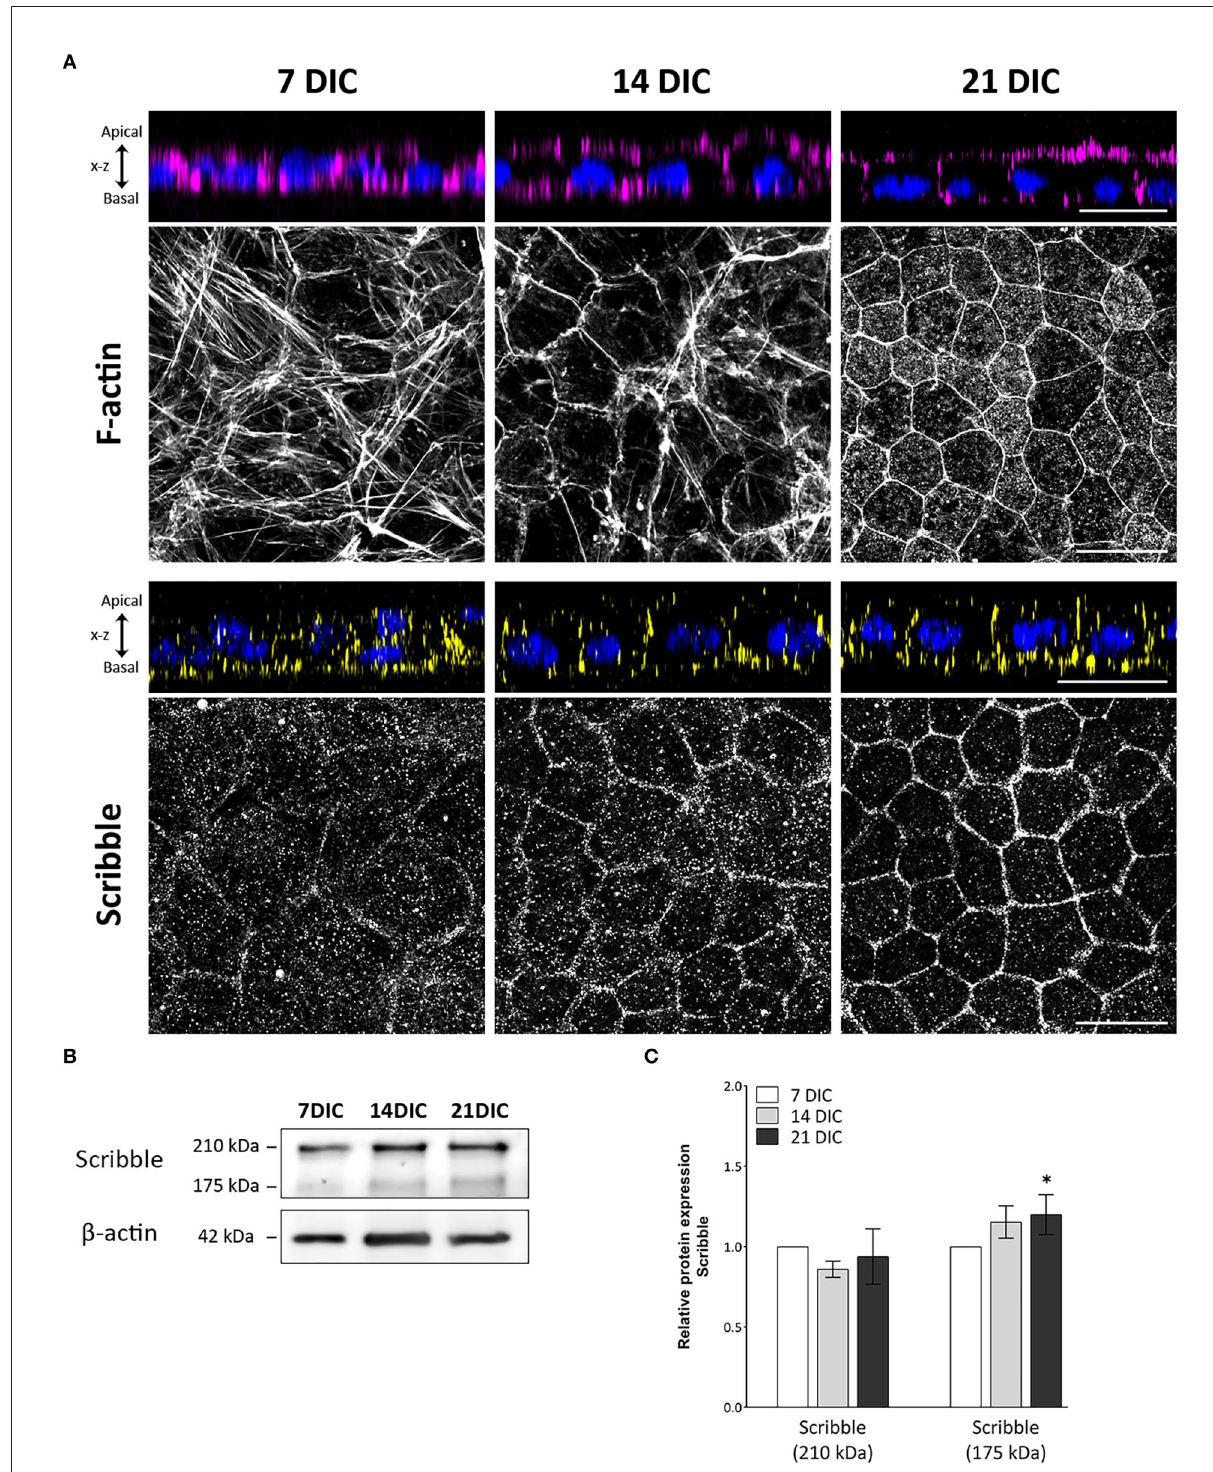
FIGURE1 Time-course expression pattern of actin and Scribble protein during hRPE cell development in culture. (A) Orthogonal views and corresponding z-stack maximum projections showing actin (magenta) and Scribble protein (yellow) localization as hRPE cells gradually form the mature epithelial tissue. DAPI (blue): nuclear labeling. Scale bars: 20 µ m. (B) Western blot analyses showing expression of Scribble (210 kDa) and Scribble (175 kDa) from 7 to 21 DIC. β -actin was used as loading control. (C) Graphical representation of the relative expression of Scribble (210 kDa) and Scribble (175 kDa) during the development of hRPE cells in culture. In both cases, 7 DIC ( n = 9), 14 DIC ( n = 9), and 21 DIC ( n = 9). DIC in (A–C) :